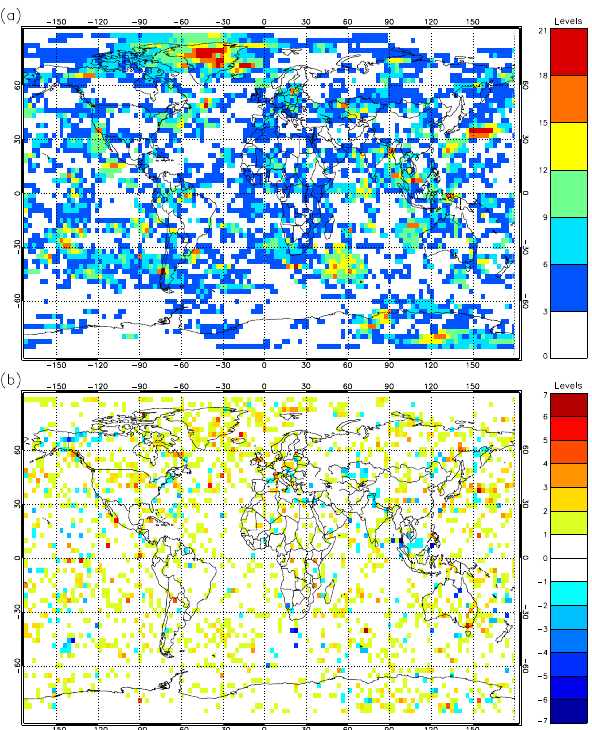
Fig. 8. A map showing regional values of (a) the number of model levels (from a total of 31) where F > F α , and (b) the difference between unperturbed and perturbed data in number of model levels where F > F α for the case of N 10 .